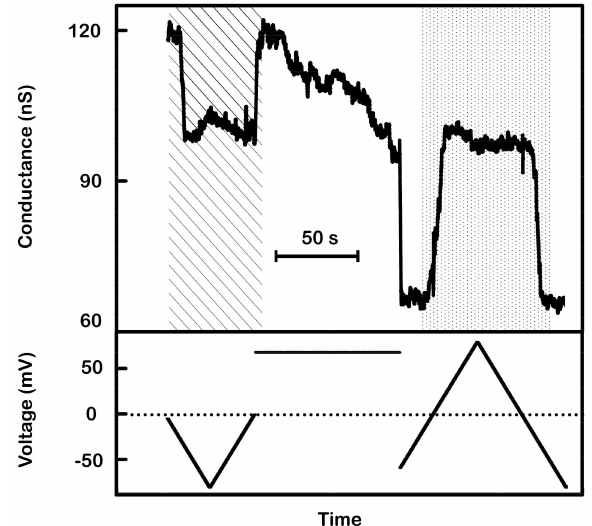
Figure 11. Supportive evidence of the model: activation of non-responding triplins by closing channel 1s. A 9 mHz (1.44 mV / s) triangular voltage ramp ( ± 80 mV) was applied to a membrane containing many triplins. As the voltage became more negative the conductance decreased rapidly by 17 nS, equivalent to the closure of 11 channel 2’s (each 1.5 nS) (in striped region). As the voltage moved toward zero, that same conductance increased once again indicating the reopening of those channels. Thus, only 11 triplins had a closed channel 1 and were capable of gating. The subsequent application of + 70 mV for 85 s produced a conductance decrement of 24 nS, corresponding to the closure of 16 channel 1s. Reapplication of the voltage ramp (dotted region) showed conductance changes at negative potentials of 38 nS, equivalent to the closure and reopening of 25 to 27 channel